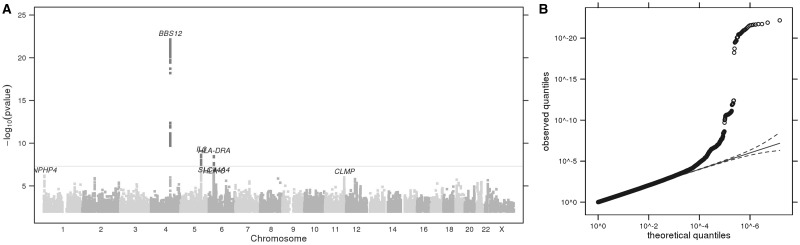
(A) Manhattan plot showing GWS loci for perceived attractiveness to mosquitoes. The horizontal grey line corresponds to P= 5 × 10−8, and results above this threshold are shown in dark grey. Gene labels are annotated as the nearby genes to the significant SNPs. λ = 1.027. (B) Quantile-quantile plot (insert). Observed P values versus theoretical P values under the null hypothesis of no association, plotted on a log scale. The solid black line is shown with a slope of 1, and dashed black lines represent a 95% confidence envelope under the assumption that the test results are independent.